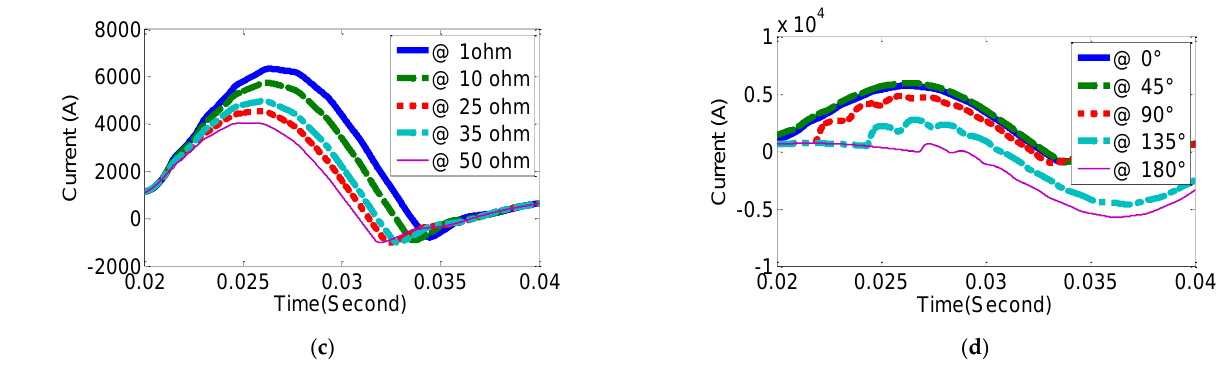
Figure 4. Sending end signals LG/Phase at different location, fault resistance, and inception angles. ( a ). (LG)/Phase a at 190 km. ( b ). (LG)/Phase a at different locations. ( c ). (LG)/phase a at different fault resistances. ( d ). (LG)/Phase a at different inception angles.